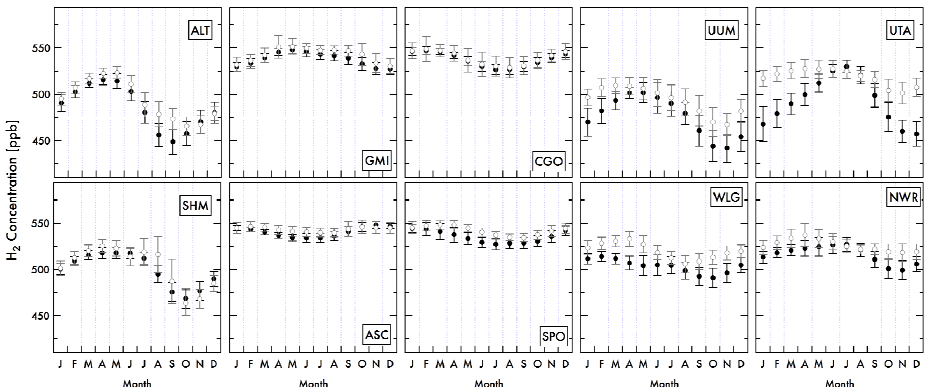
Fig. 4. Monthly mean H 2 mixing ratios at the 10 selected observation sites. Abbreviations for each site are expressed in Table 1. Closed and open circles are the observed and calculated values, respectively. Error bars represent the standard deviations of the multi-year average during the period 1997–2005, which arise from both the day-to-day variation and inter-annual variation of the mixing ratio.